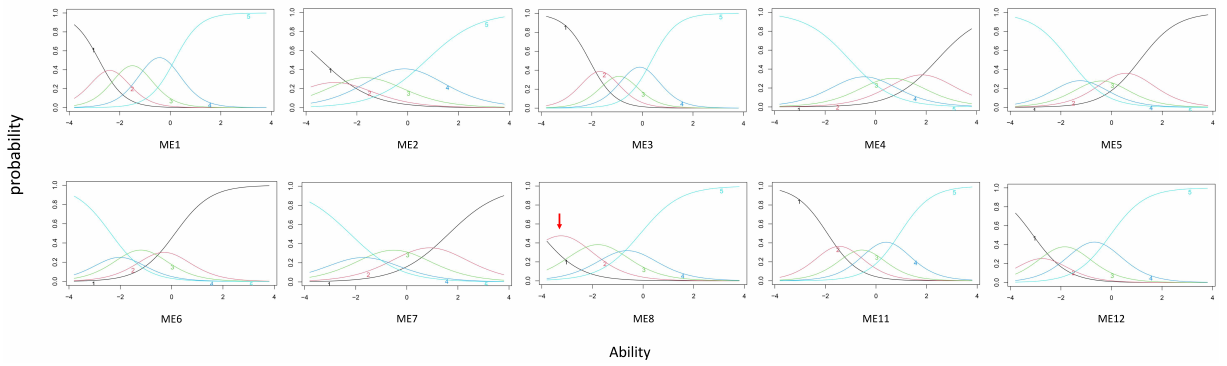
Figure 2. The response characteristic curves of items.